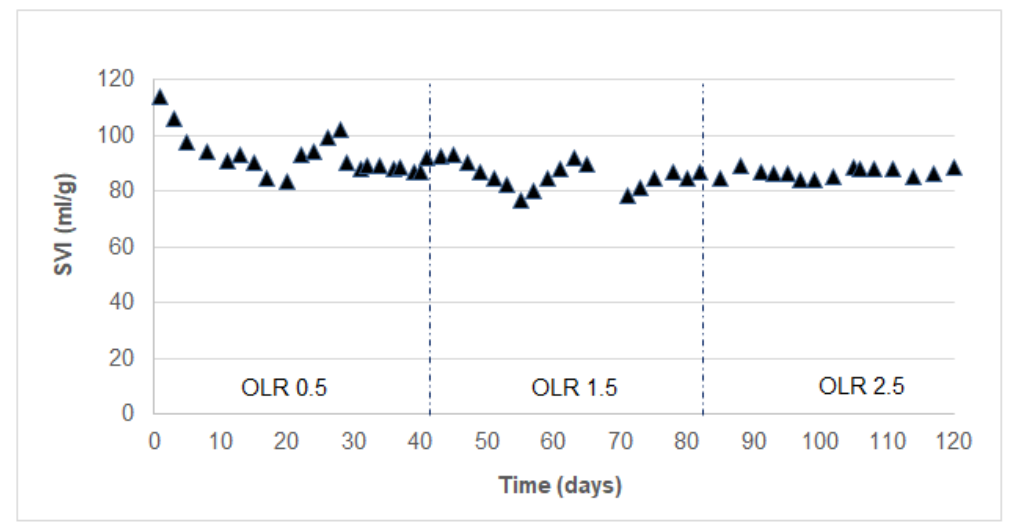
Figure 3. The sludge volume index (SVI) throughout three load rates.